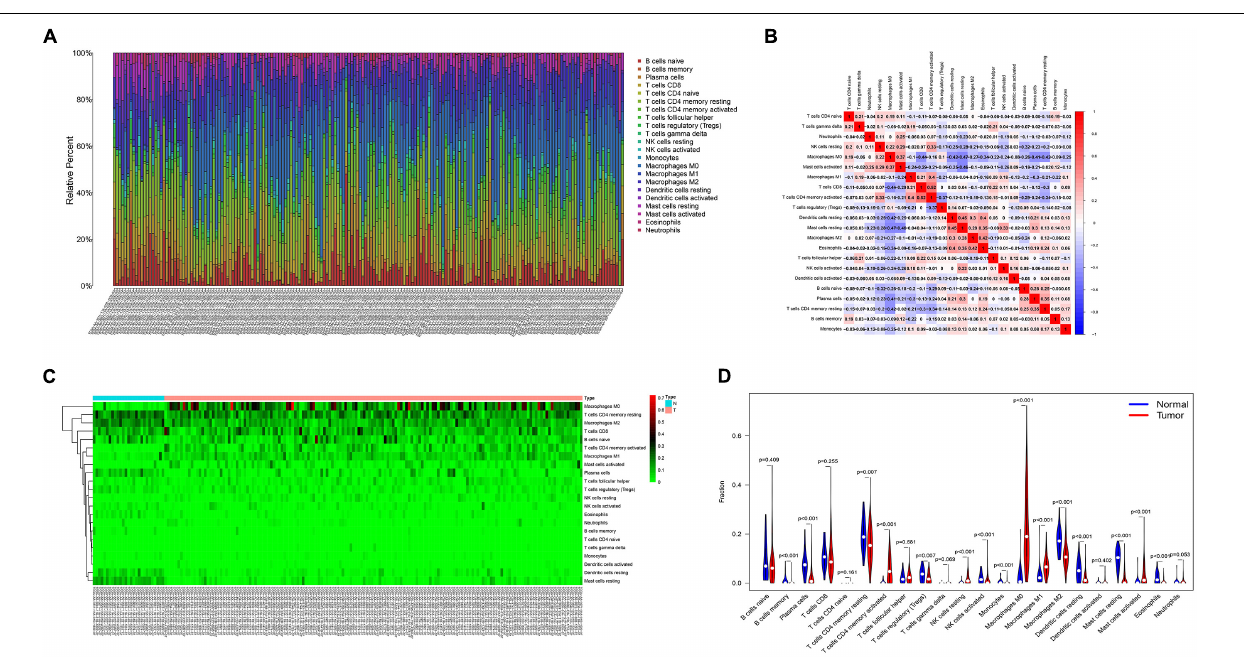
FIGURE 4 | (A) Histogram of the infiltration ratio of the 22 immune cells in tumor tissue. (B) Correlation analysis of the respective expression levels of the 22 immune cells in the tumor sample. (C) Heatmap of the difference of immune cell infiltration between cancer tissue and normal tissue adjacent to cancer. (D) Violin image of the difference of immune cell infiltration difference between cancer tissue and normal tissue adjacent to